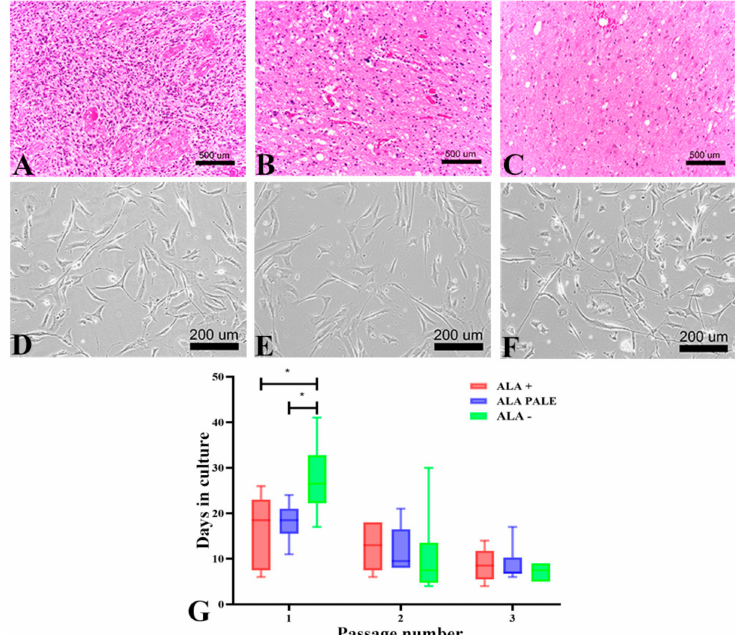
Figure 1. GASC isolated from tumor regions showing di ff erent intraoperative 5-ALA fluorescence intensity display di ff erent growth kinetics. ( A – C ) Pictures of HE-stained sections representative of 5-ALA + , 5-ALA PALE and 5-ALA − regions of a newly diagnosed GBM removed by 5-ALA FGS. ( A ) The 5-ALA + region displays features of a high-grade tumor (high cell density and mitotic activity, nuclear pleomorphism and necrosis). ( B ) The 5-ALA PALE section is characterized by a gliotic tissue infiltrated by tumor cells. ( C ) The 5-ALA − section consists of brain tissue devoid of cancer cells ( D – F ) Contrast phase images of GASC isolated from 5-ALA + ( D ), 5-ALA PALE ( E ) and 5-ALA − ( F ) regions showing, in vitro, a similar fibroblast-like morphology, typical of adult mesenchymal stem cells. ( G ) The histograms represent the growth kinetic of GASC-ALA + , GASC-ALA PALE and GASC-ALA − , as evaluated at the first, second and third passage in culture. Values were calculated by counting days between passages. Data are presented as interleaved box and whiskers ( n = 6). * p value < 0.05. Statistical analysis was performed by a Student’s t -test (GraphPad Prism